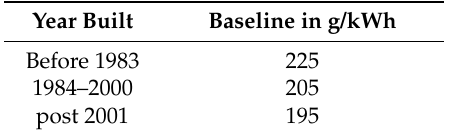
Table 1. Baseline fuel consumption for high speed diesel